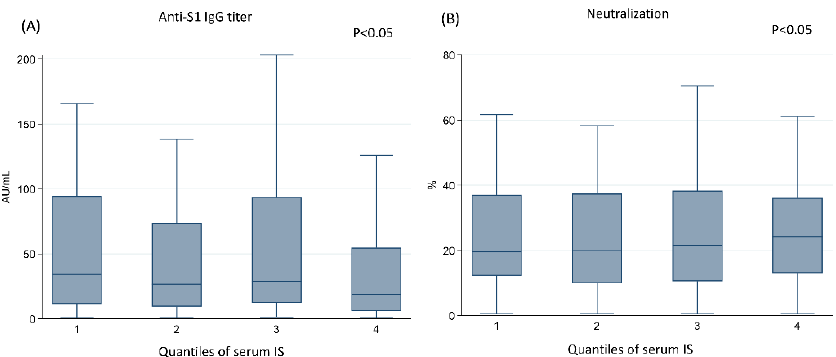
Figure 4. Comparisons of the ( A ) anti-S1 IgG titer and ( B ) sVNT-measured neutralization based on the quartiles of the serum indoxyl sulfate concentration by p for trend. Abbreviations: AU, arbitrary unit; IS, indoxyl sulfate; S1, the S1 sub-unit of the spike protein; sVNT, surrogate virus neutralization test. Table 2 demonstrates the factors linked to the titer of anti-S1 IgG. In the crude model, higher IS concentrations (Q2 to Q4) were associated with lower circulating anti-S1 antibody levels compared with the lower IS concentration in the Q1 group (reference). Elderly